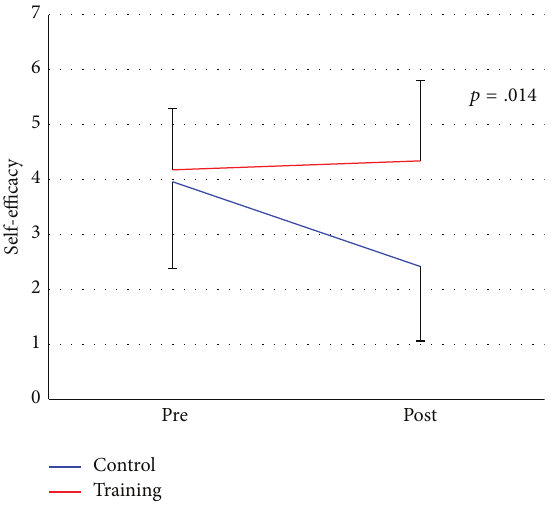
Figure 3: Change of self-efficacy in the training group and control group. Note . Values as means; error bars indicate standard